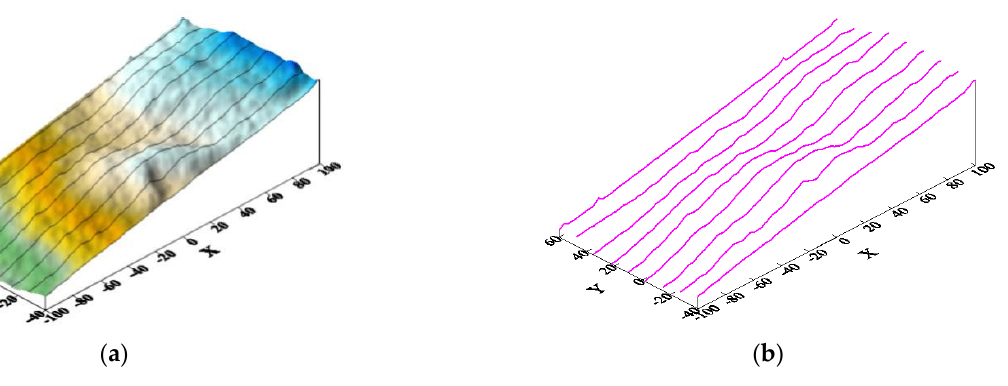
Figure 4. Profile extraction ( a ) and calculation of JRC values ( b ).